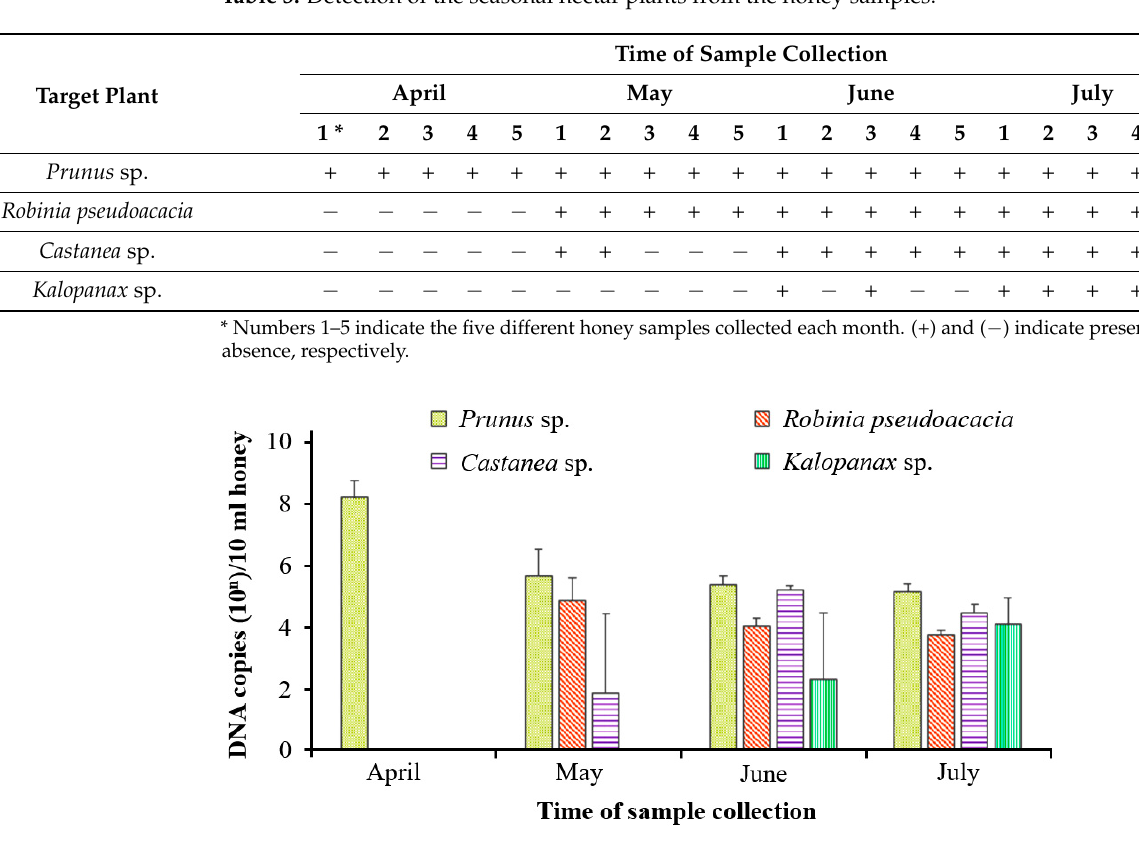
Figure 1. Quantity of pollen DNA of the targeted plants in the honey samples. The quantity of DNA of each targeted plant is the average number of DNA copies calculated from five samples collected each month (mean + standard deviation).